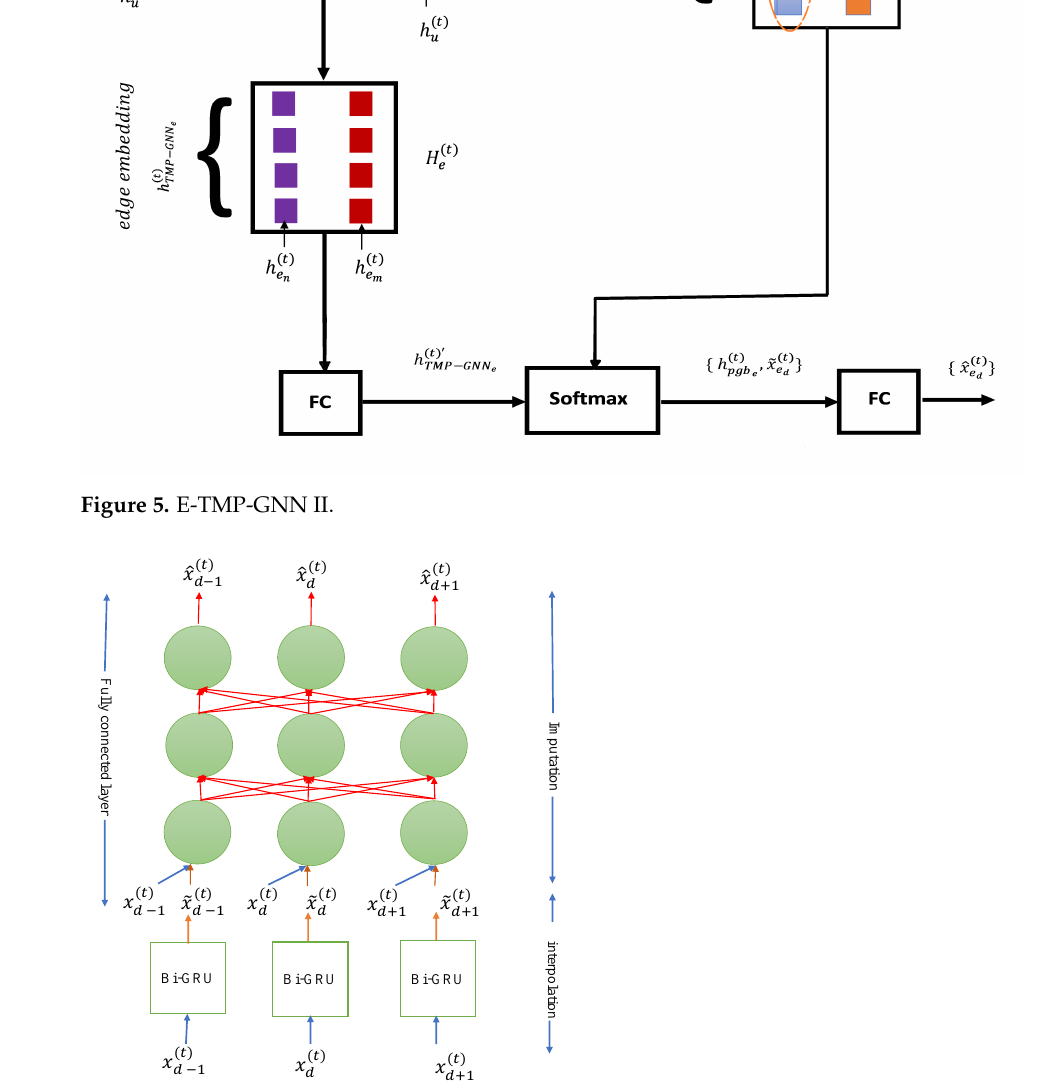
Figure 6. M-RNN architecture in time domain based on the theory in